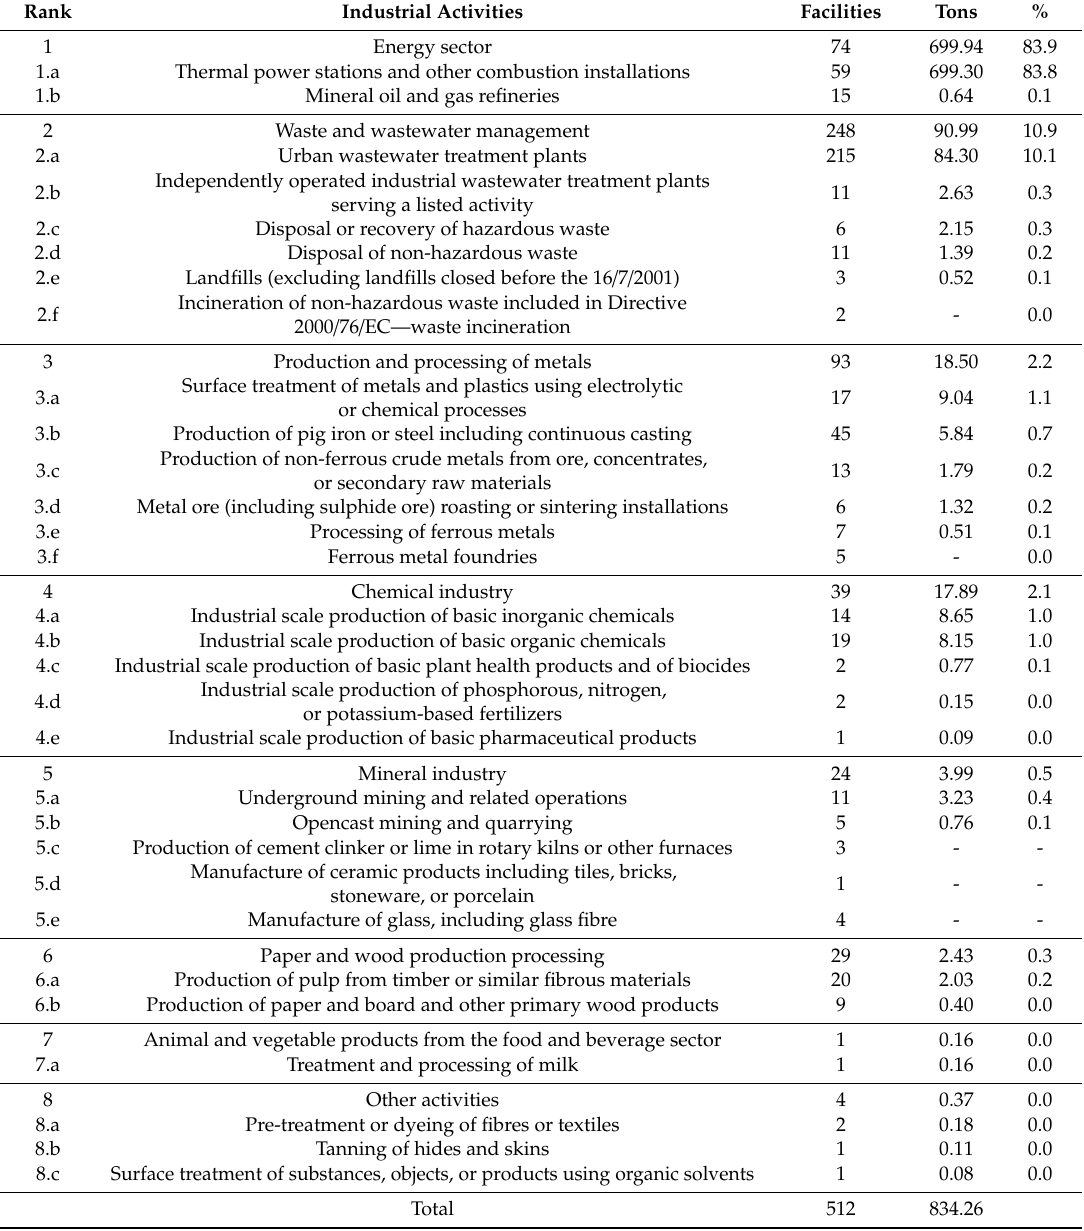
Table A1. Amount of chromium and its compounds released in European waters per industrial activity, data from the European Environment Agency related to the year 2017 (data source: